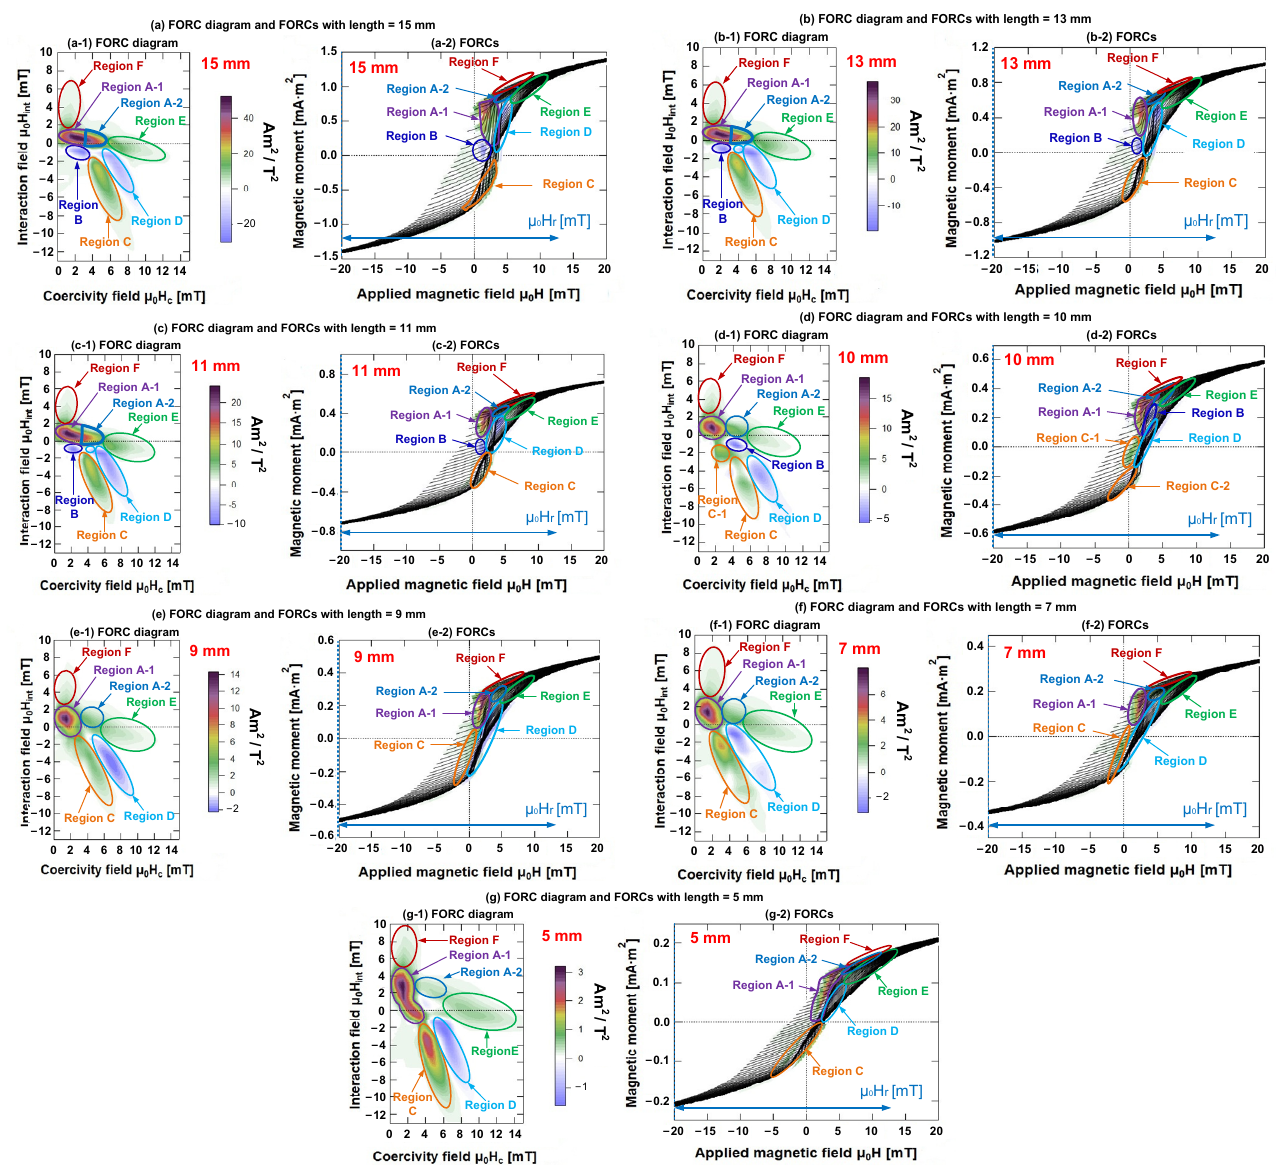
Figure 8. FORCs and FORC diagrams of Wiegand wires at varying lengths. ( a ) Length = 15 mm; ( b ) length = 13 mm; ( c ) length = 11 mm; ( d ) length = 10 mm; ( e ) length = 9 mm; ( f ) length = 7 mm; and ( g ) length = 5 mm.